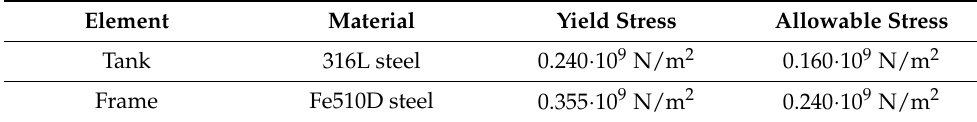
Figure 5. Front view.